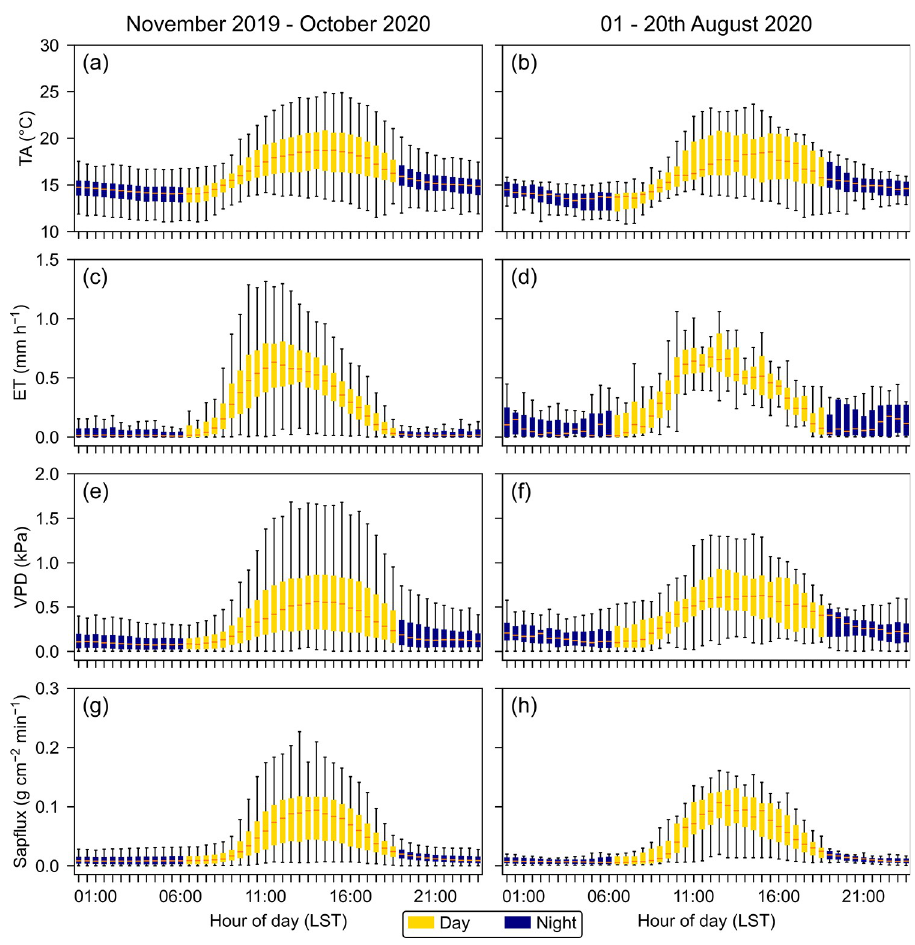
Fig 4. Diurnal courses of above-canopy air temperature (TA,˚C), evapotranspiration (ET, mm h -1 ), vapor pressure deficit (VPD, kPa), and sap flux (g cm -2 min -1 ). The left column shows the time period November 2019